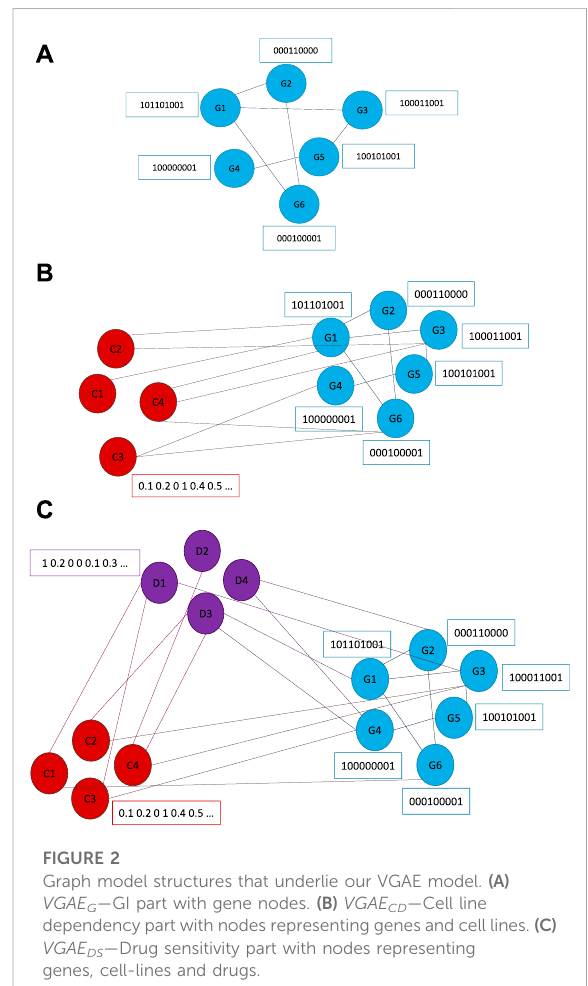
FIGURE 2 Graph model structures that underlie our VGAE model. (A) VGAE G — GI part with gene nodes. (B) VGAE CD — Cell line dependency part with nodes representing genes and cell lines. (C) VGAE DS — Drug sensitivity part with nodes representing genes, cell-lines and drugs.